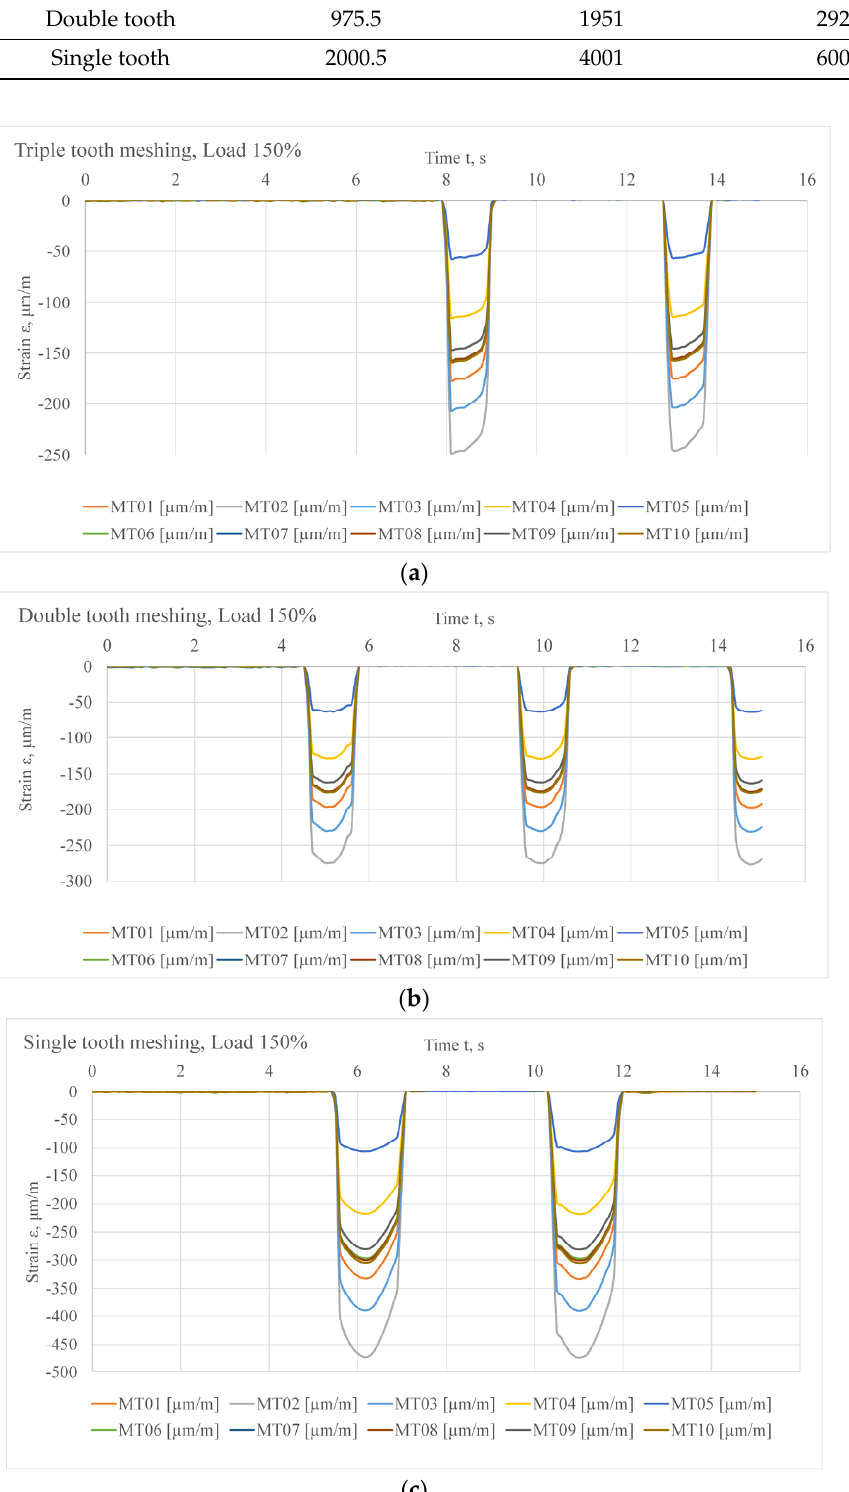
Figure 7. Strain results obtained in the time domain for the external load of 150% of F nmax for: ( a ) triple − tooth meshing, ( b ) double − tooth meshing, and ( c ) single − tooth meshing.